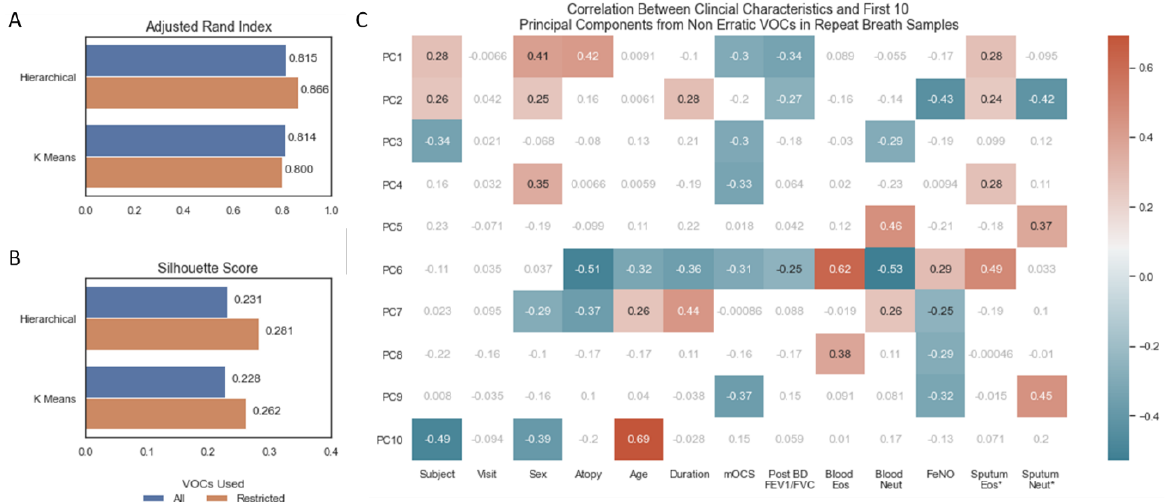
Figure 3. ( A ) Barplot of adjusted rand index for assessing agreement in unsupervised machine learning algorithm prediction of 14 clusters and 14 subject identifiers. ( B ) Fowles Mallows Score for assessing agreement in unsupervised machine learning algorithm prediction of 14 clusters and 14 subject identifiers. ( C ) Heatmap of correlation between continuous clinical characteristics and the first 10 principal components, non-significant correlations in grey/white, positive and negative correlations with p -value < 0.05 in red and blue, respectively. * Sputum Eosinophils and Sputum Neutrophil Percentages log transformed. Volatile organic compounds (VOCs), principal component (PC), maintenance oral corticosteroid treatment dose (mOCS), post bronchodilator ratio between forced expiratory volume in 1 s and forced vital capacity (Post BD FEV1/FVC), eosinophils (Eos), neutrophils (Neut), fraction of exhaled nitric oxide (FeNO).